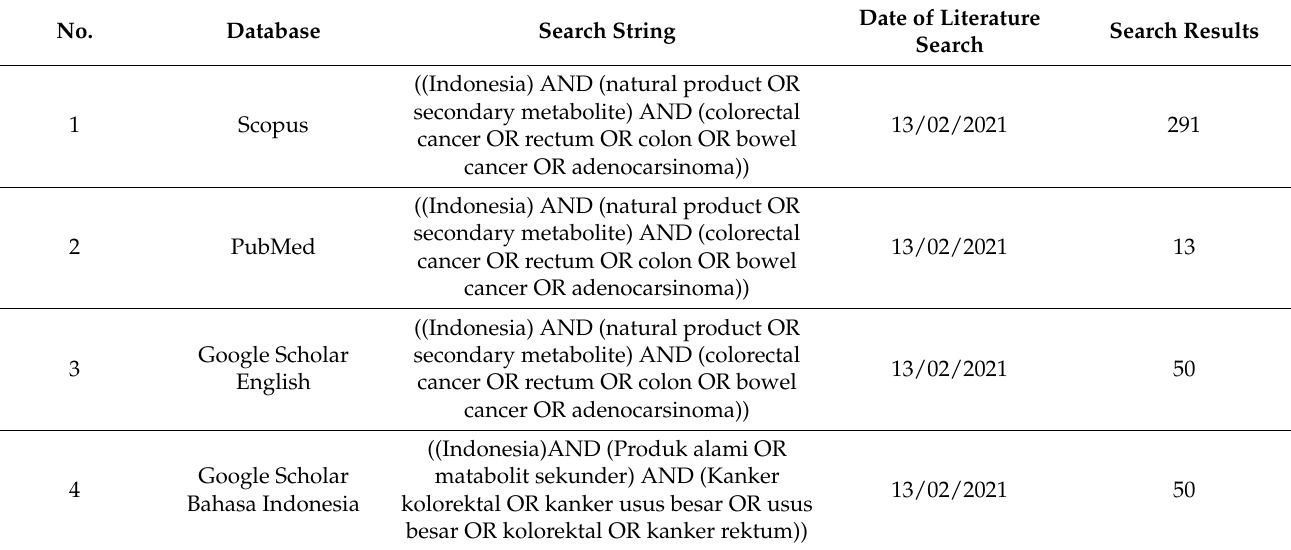
Table 2. Literature search